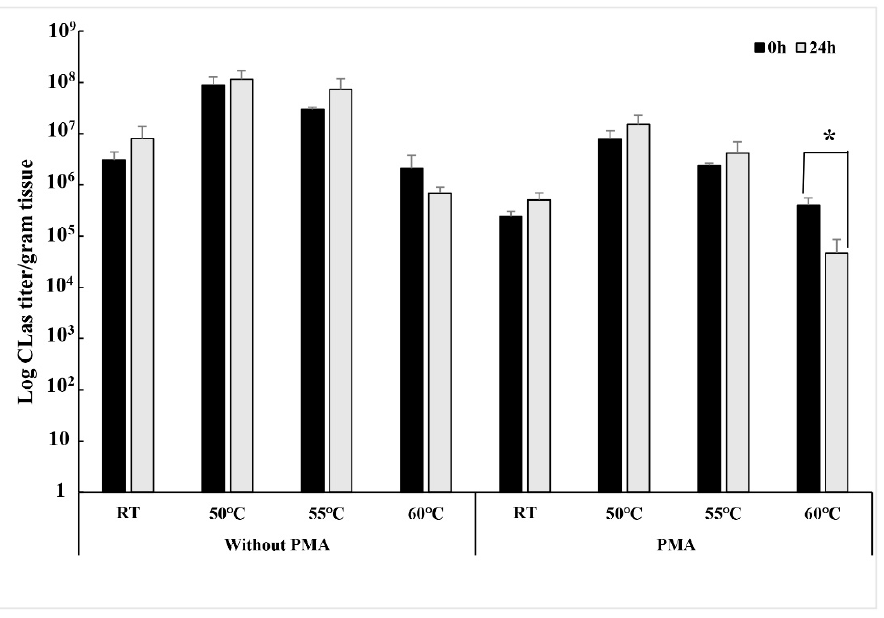
Figure 2. CLas titer detected by PMA-qPCR in HLB-affected citrus cuttings under heat treatment at various temperatures. Significant differences between different time points are indicated by * p ≤ 0.05. Standard error of the mean is indicated by a vertical line.